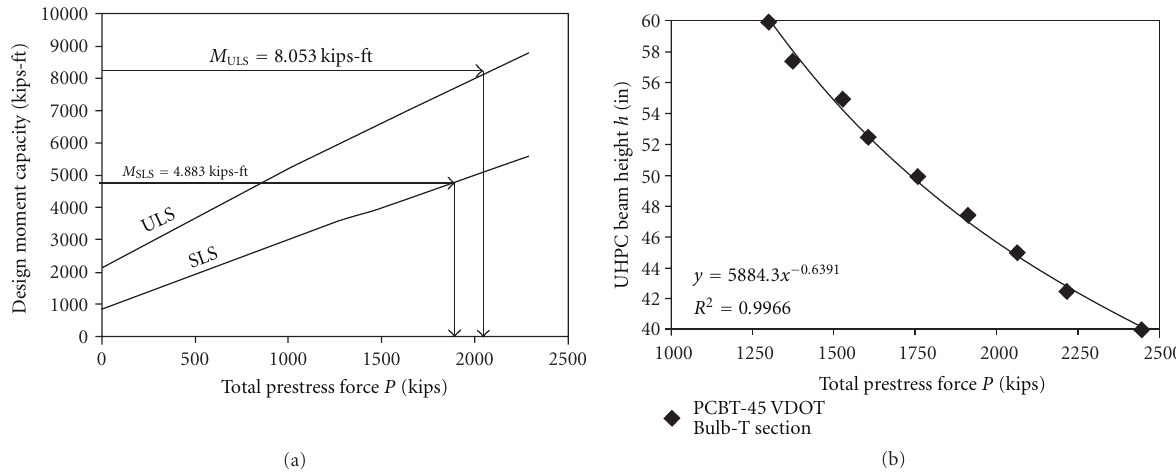
Figure 6: (a) Design moment capacity of the composite section as a function of the total prestressing force; (b) UHPC beam height versus required prestressing force satisfying SLS and ULS factored design moments.